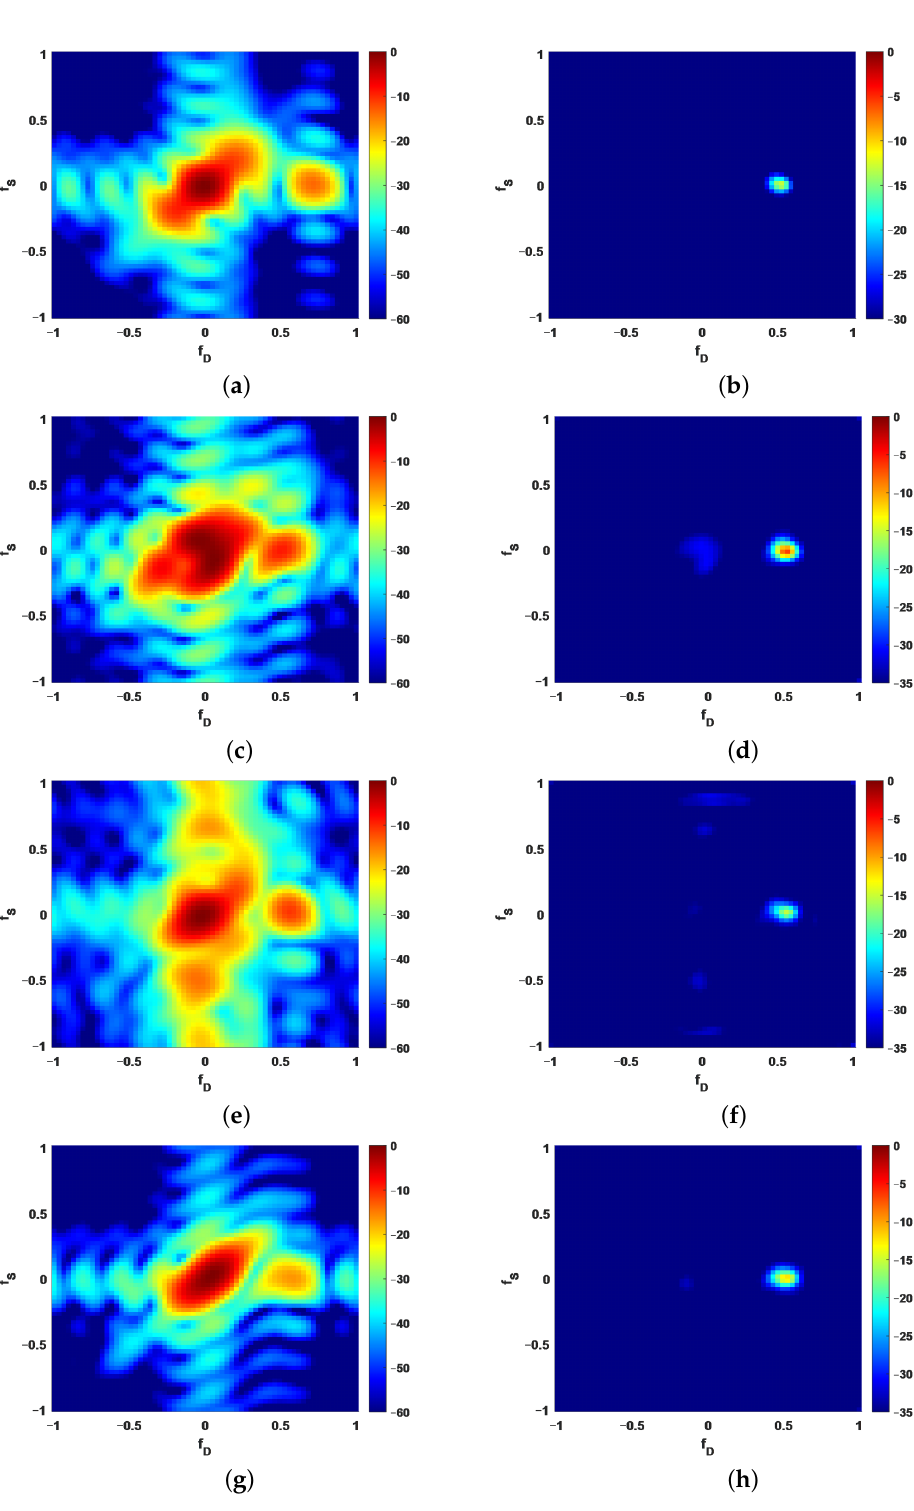
Figure 5. Processing results of different clutter environments with SCR = − 15 dB in the case where the target and clutter are distinguishable. ( a , b ) ideal case; ( c , d ) in the presence of aircraft crabbing; ( e , f ) in the presence of spatial error; ( g , h ) in the presence of